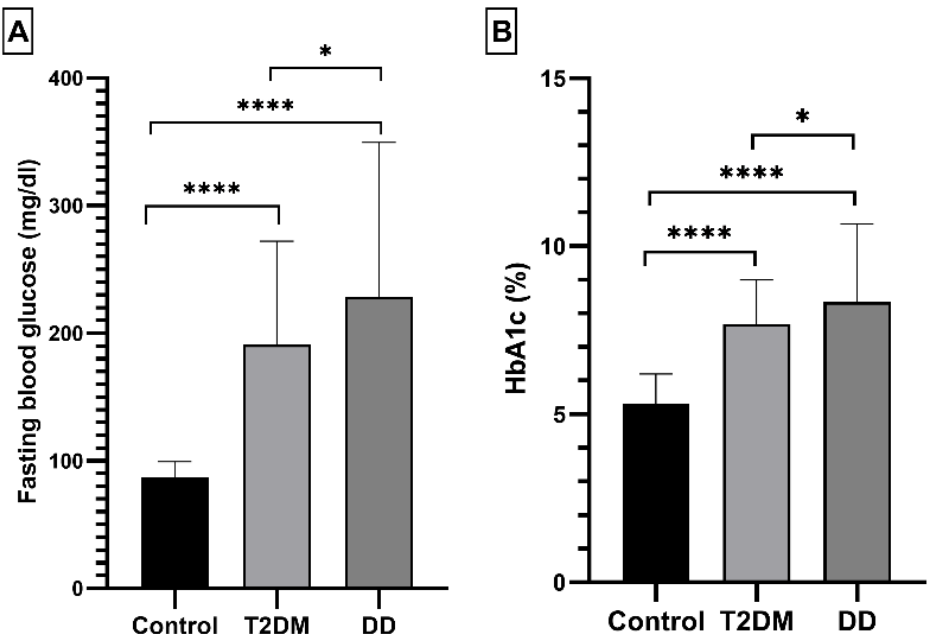
Figure 1. The differences in HbA1c (%) and fasting blood glucose between the control, T2DM, and DD groups. Each bar represents the group’s mean. Error bars are ± standard deviation. Note: T2DM and DD data are compared with the control group. * and **** denote statistical significance ( p < 0.01; p < 0.0001 respectively). ( A ): Comparison of BSF (mg/dl), ( B ); Comparison of HbA1c (mmol/mol).